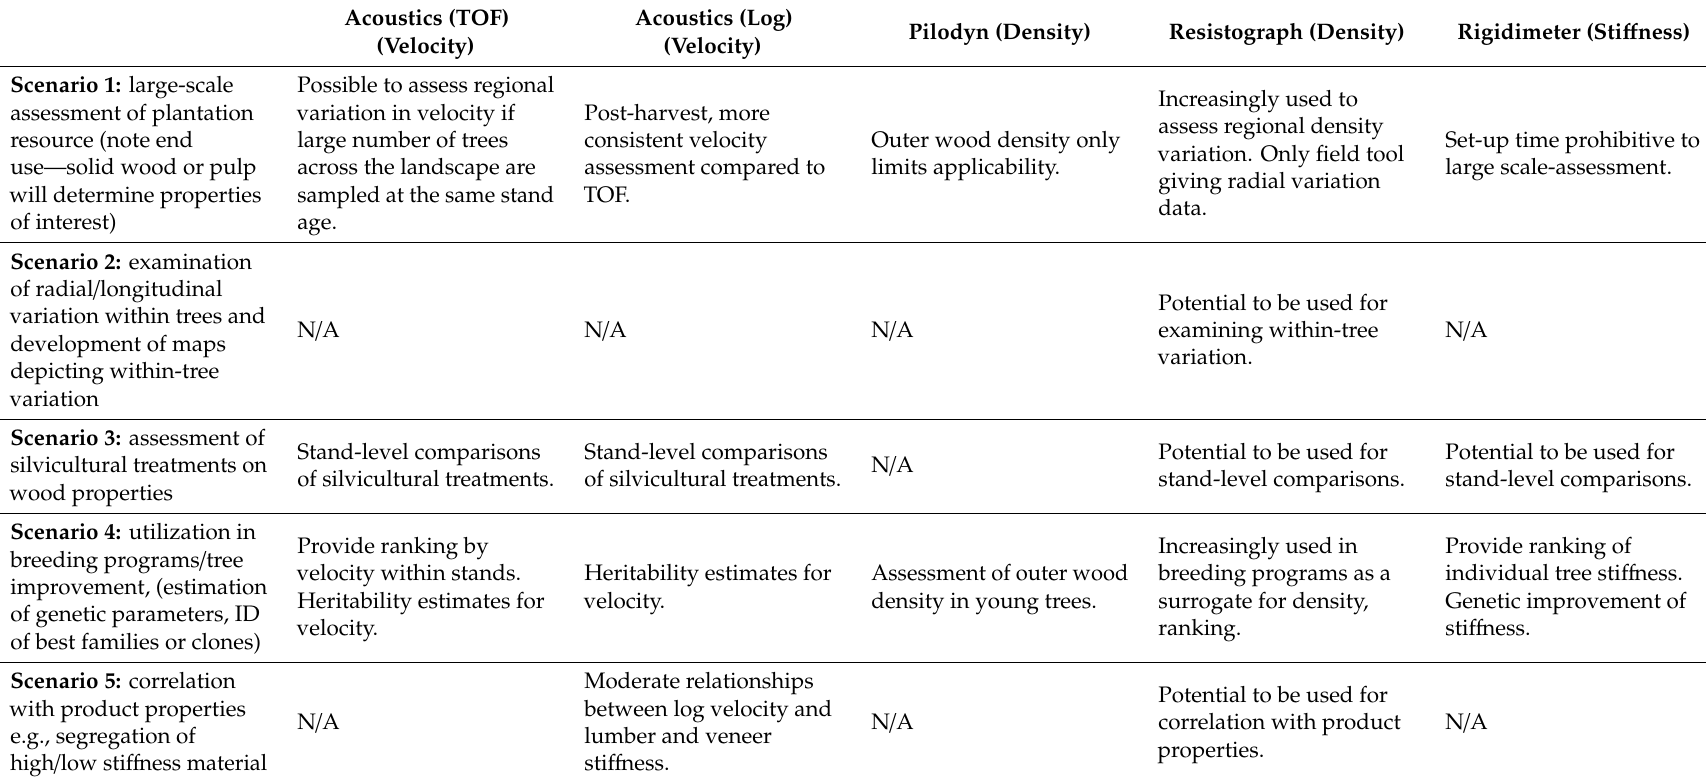
Table 2. Applicability of di ff erent field based non-destructive evaluation (NDE) tools to operational and / or research